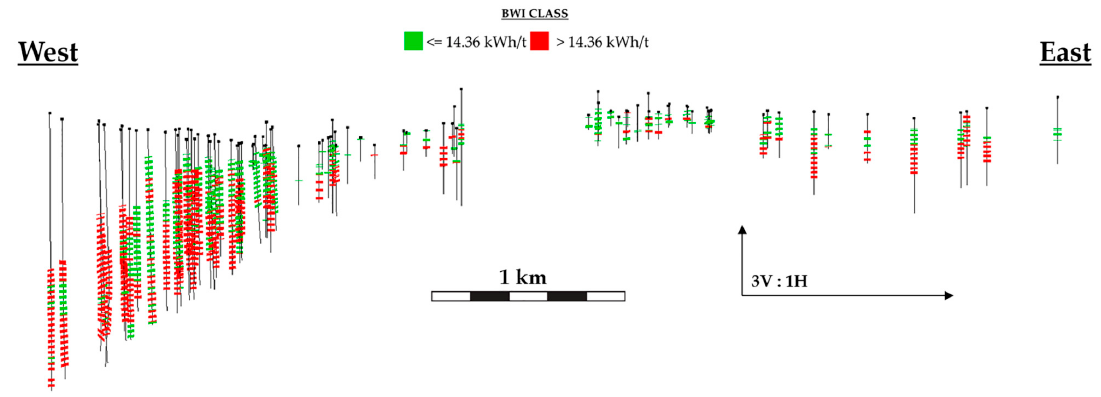
Figure 18. Spatial visualization of the BWI classes, <= 14.36 kWh / t and > 14.36 kWh / t, obtained from K -means clustering of BWI sample data. Cross-section looking north at Paracatu (VEX: 3 to 1). Observations represented by BWI class membership within their drillhole sample. Section thickness includes north to south extent of mine site.